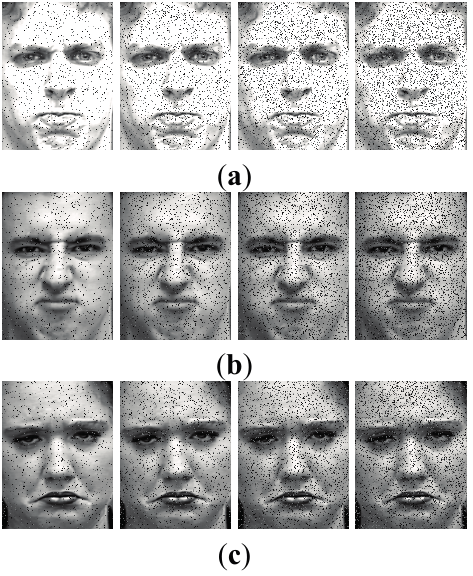
Figure 10. Facial expression with noise. ( a ) Anger; ( b ) Disgust; ( c )